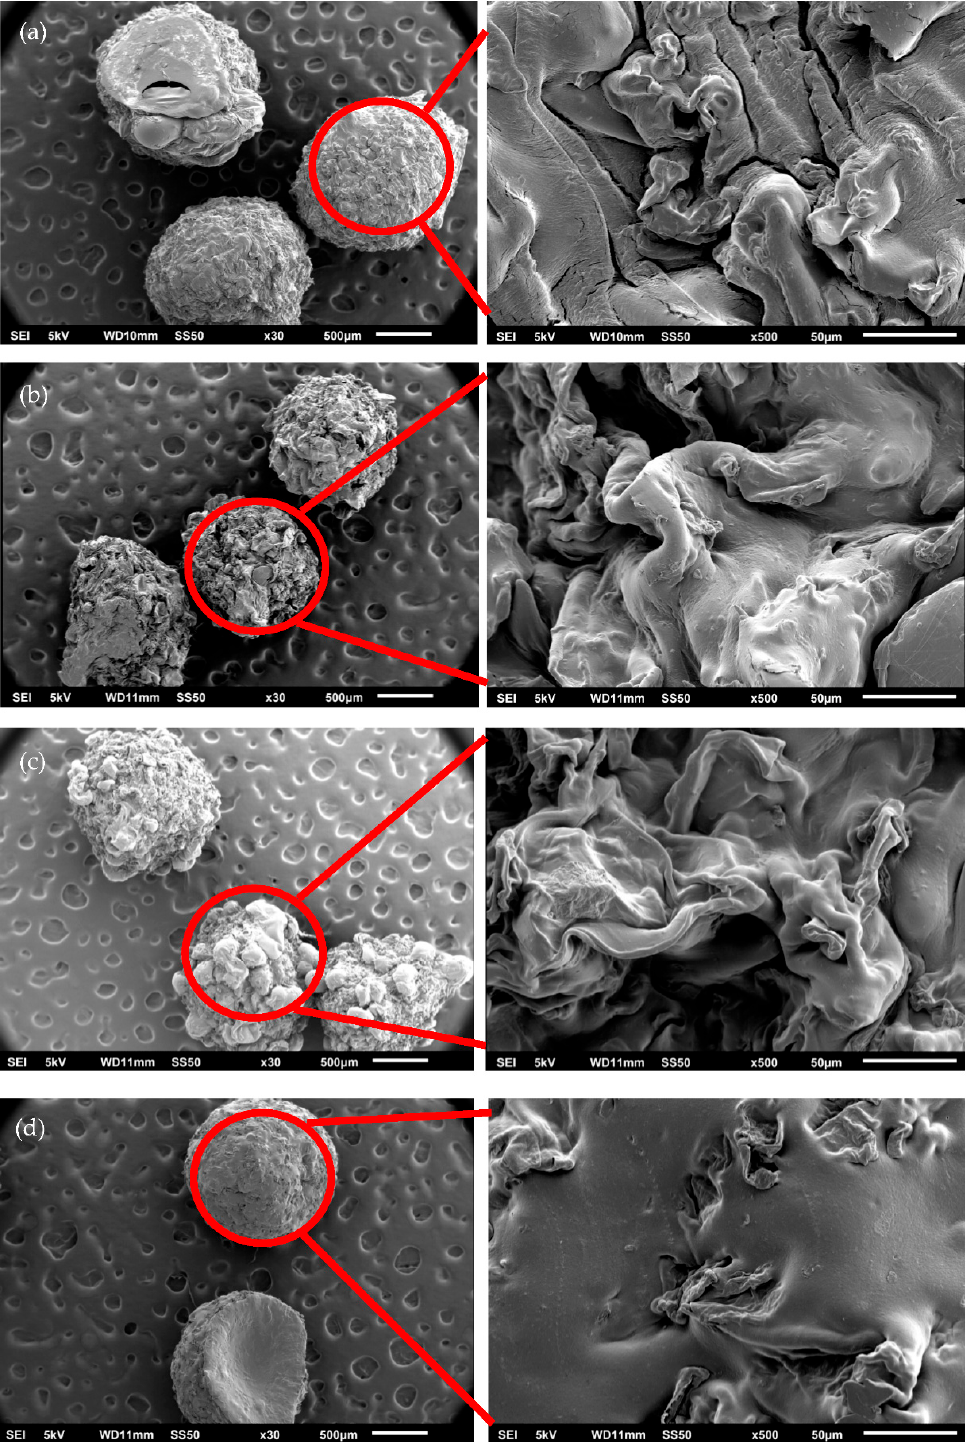
Figure 2. SEM images of hydrogel beads: ( a ) HAF-SA, ( b ) HAF-CS, ( c ) MHAF-SA, and ( d ) MHAF-CS.